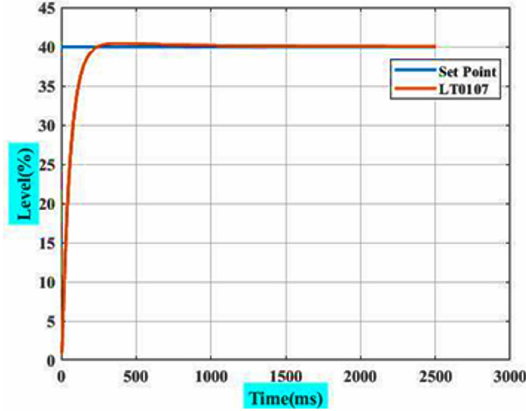
Figure 9. System response with closed-loop PID auto-tuning.